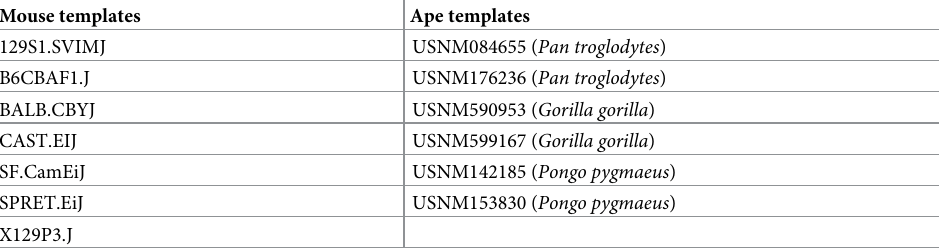
Table 2. K-means selected